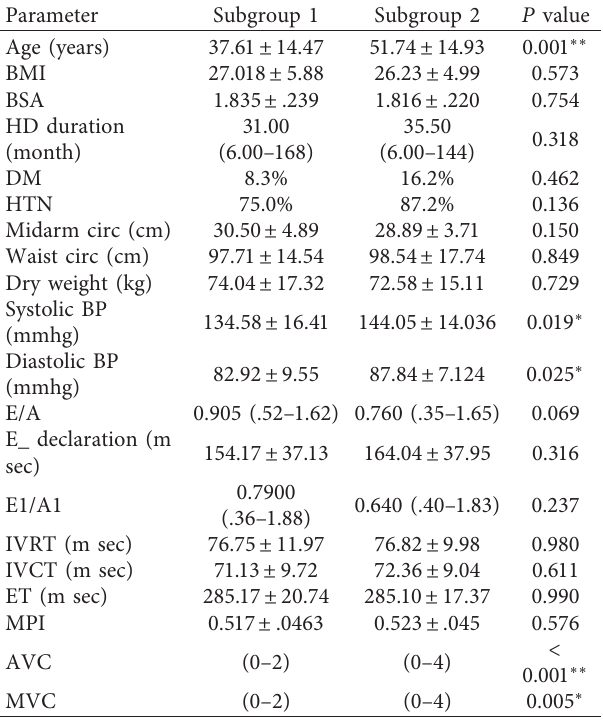
Table 2: Comparative analysis of some demographic and echo- cardiographic data among the studied two